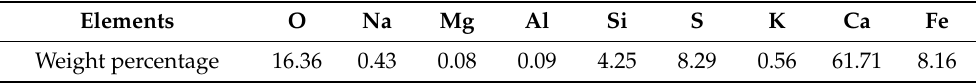
Table 7. The weight percentage of elements in concrete containing type II